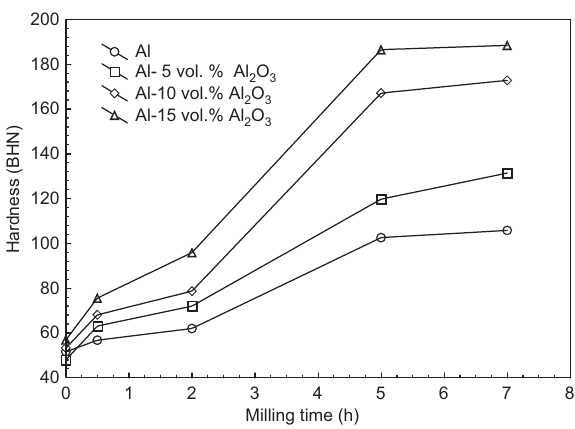
Figure 13 Hardness of the Al and composites vs. milling time at 700